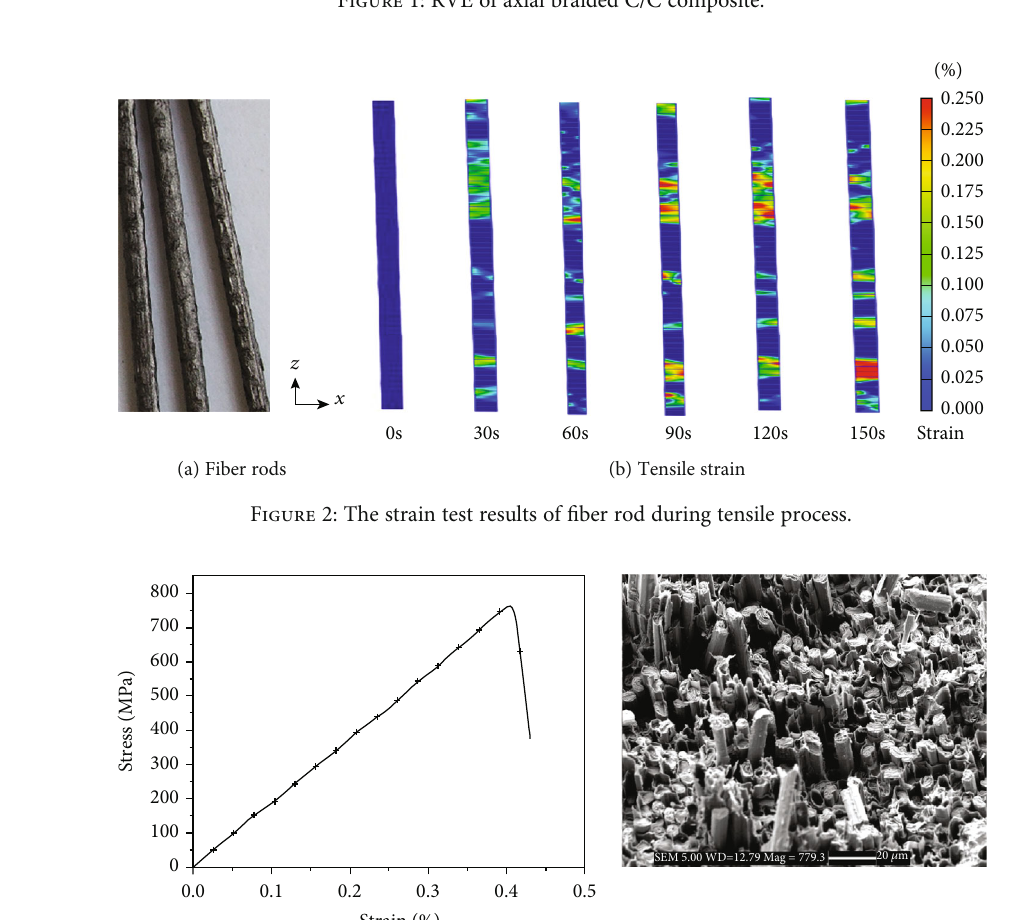
Figure 1: RVE of axial braided C/C composite.